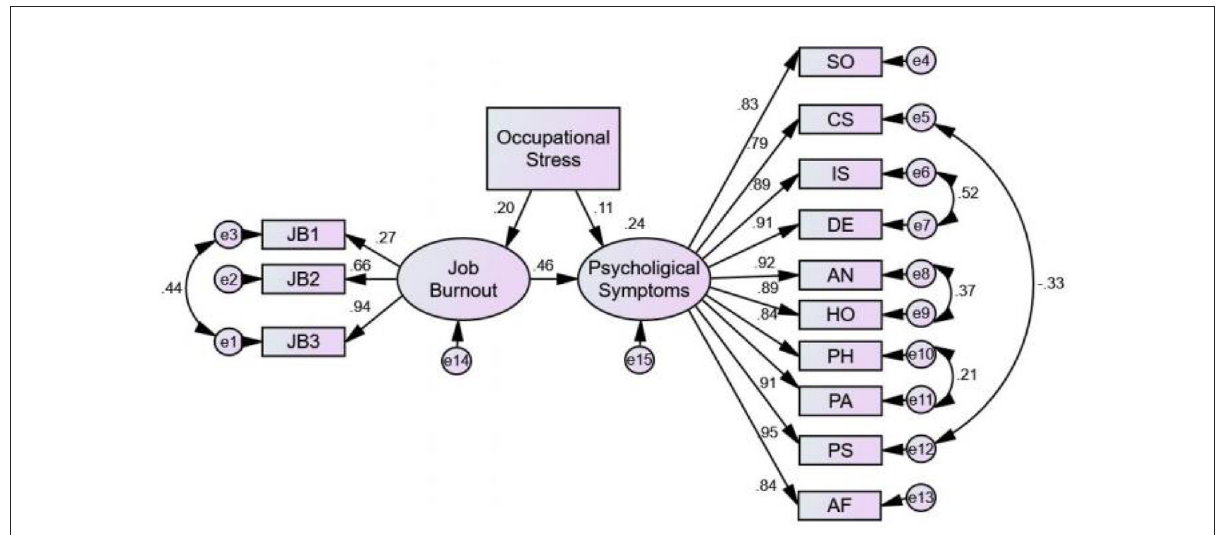
FIGURE2 Structural equation modeling results for the relationship between occupational stress, burnout, and psychological symptoms. All coefficients in the figure are standardized and significant at the 0.05 level. JBI, emotional exhaustion; JB2, depersonalization; JB3, reduced personal accomplishment; SO, Somatization; CS, Compulsive symptoms; IS, Interpersonal sensitivity; DE,